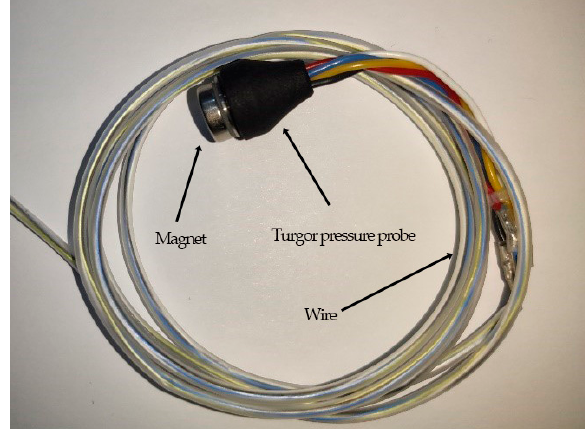
Figure 2. Physical view of sensor probe.